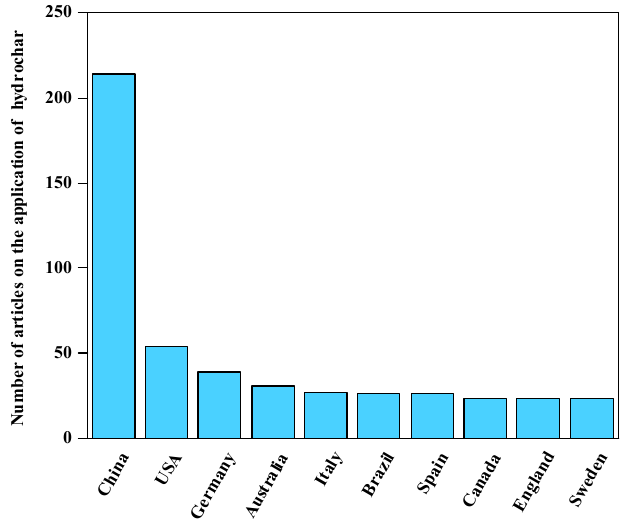
Figure 2. The number of articles on the application of hydrochar area over the past five years. In Figure 3, it can see the main keywords used in the articles on the application of hydrochar, and the search term “application of hydrochar” was used on the web of science. The term “hydrothermal carbonization” was the most controlled term, followed by “adsorption”. This may confirm that the most current application of biomass waste is in the adsorption function in water, including adsorption of heavy metal pollutants, phosphorus pollution, etc.; followed by “biomass waste”, “sewage sludge” and “This probably explains why biomass waste and sewage sludge are by far the most researched and useful activated biocarbon